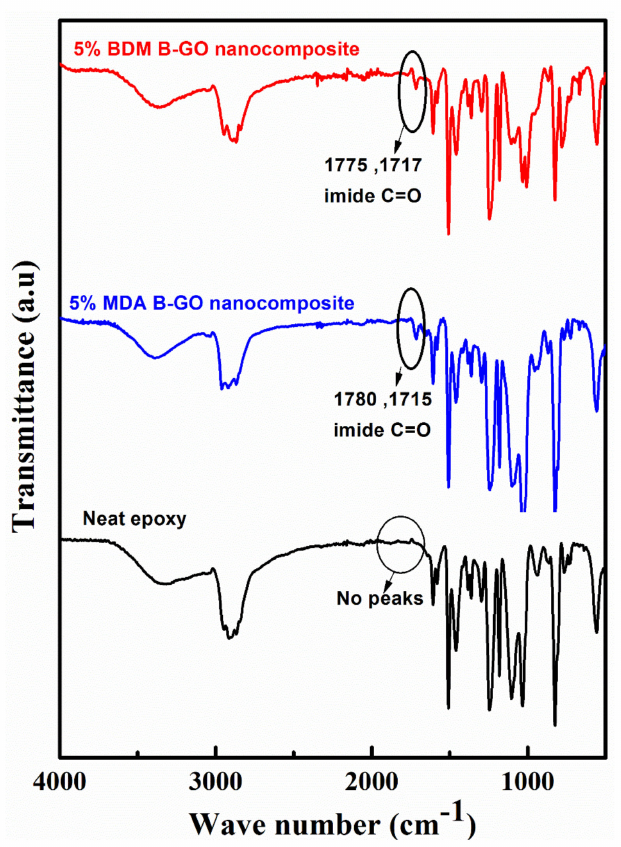
Figure 4. FTIR spectra of neat epoxy and 5% MDA-B-GO/ BDM-B-GO-epoxy